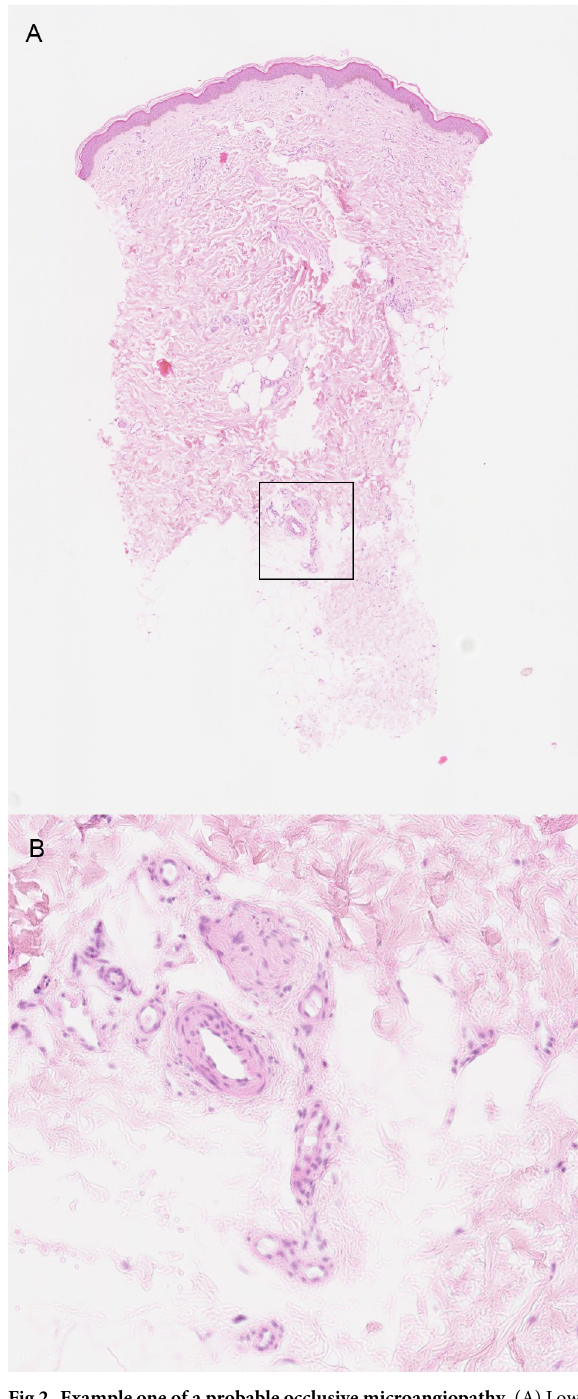
Fig 2. Example one of a probable occlusive microangiopathy. (A) Low magnification shows that the abnormal arteries are located in the deep dermis (box) (H&E, 25x). (B) In detail, multiple arteries with a patent lumen and a thickened vessel wall, suggesting neovascularization (H&E,